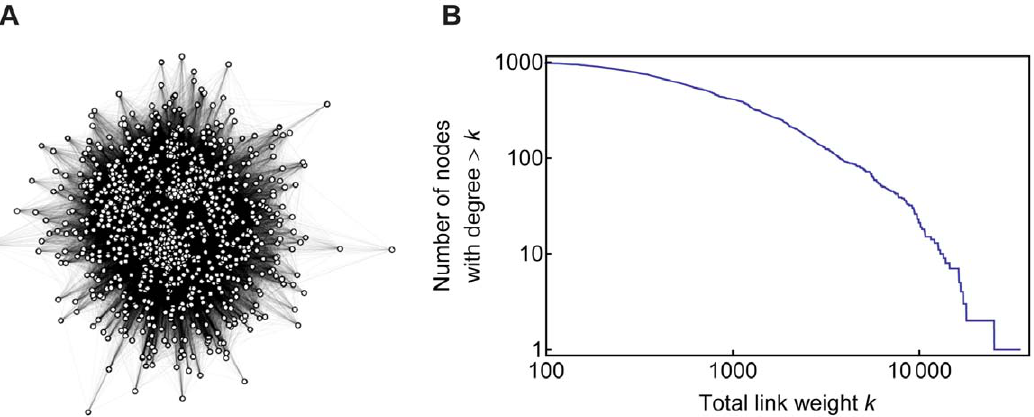
Figure 3. Reconstructed network of 1,000 researchers. (A) Visualized network. Each node represents a researcher. (B) Distribution of total link weights of nodes, plotted as a complementary cumulative distribution function (CCDF).